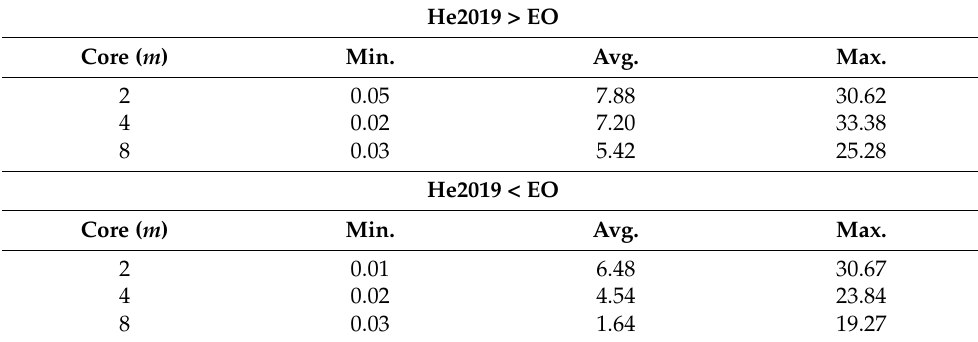
Table 1. Advantage: percentage of improvement in joint ordering policy.